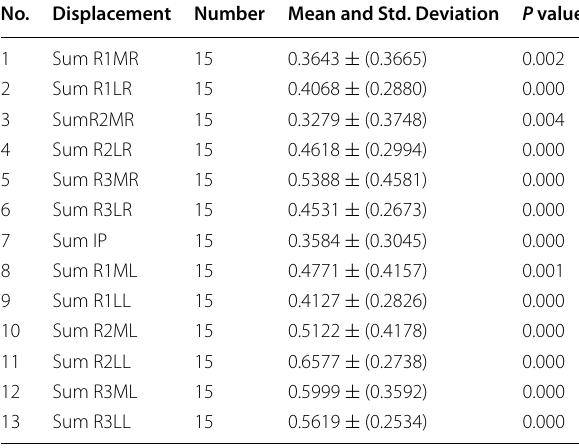
Table 2 One-sample statistics, comparison in coordination changes of rugae in pre- and post-treatment in extraction group–right rugae (1–6); and left rugae and incisive papilla (7–13) No. Displacement Number Mean and Std. Deviation P value